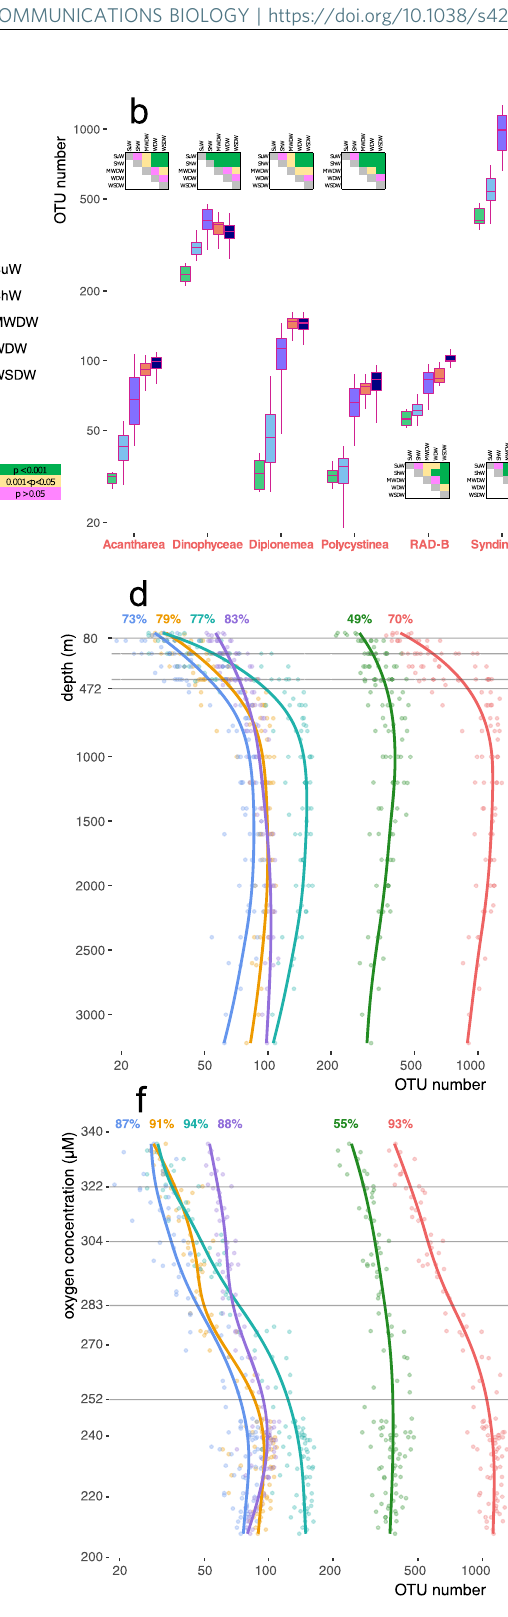
Pernice et al. 9 conducted a global sampling in the bathypelagic zone mainly between 30°N and 30°S and reported metabarcoding (V4 region of the 18S rRNA gene) and metagenomic data for protists; NADW, WSDW, CDW, and their mixtures were sam- pled. Ascomycota and Basidiomycota were abundant in the bathypelagic waters of the Paci fi c and Indian Oceans (in